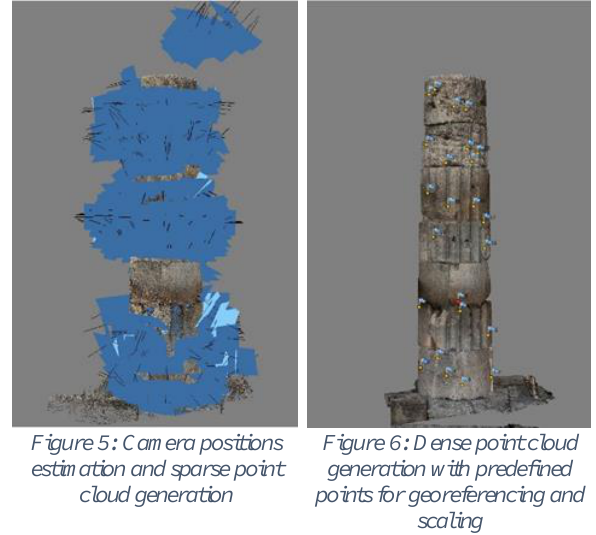
Figure 5: Camera positions estimation and sparse point cloud generation